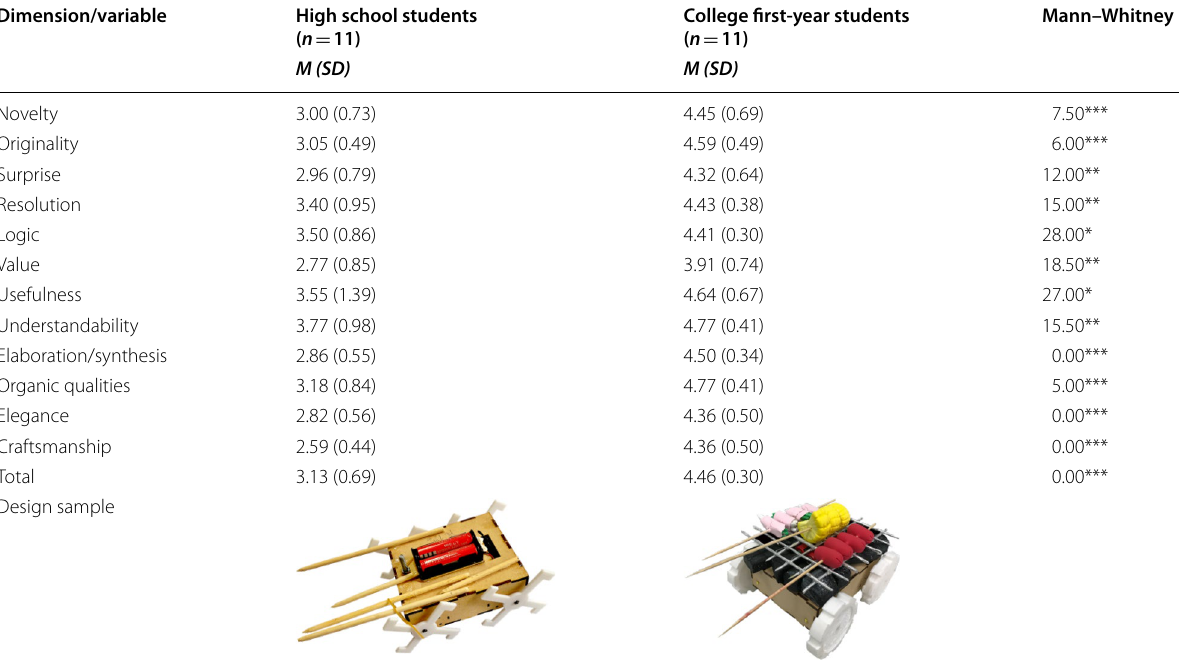
Table 3 Means and standard deviations of the CPAM scores for the two student groups